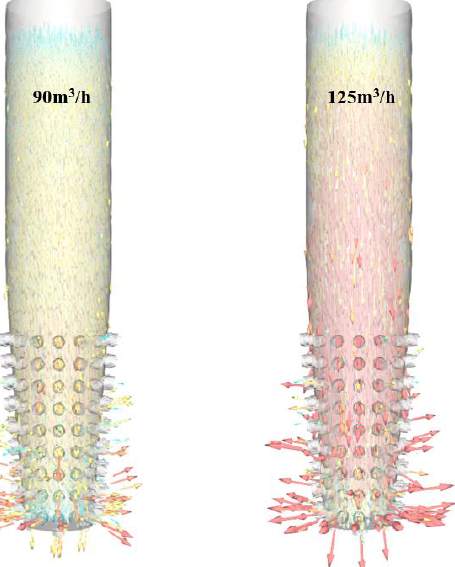
Figure 18. Flow properties of LCMs under the action of the low, medium, and high displacement fluids. Figures 19 and 20 reflect the effect of different displacements on LCMs. The reduction of the fluid displacement will reduce the overflow speed of the particles, resulting in the deterioration of the flow properties. The drag force on the LCMs is also affected by the